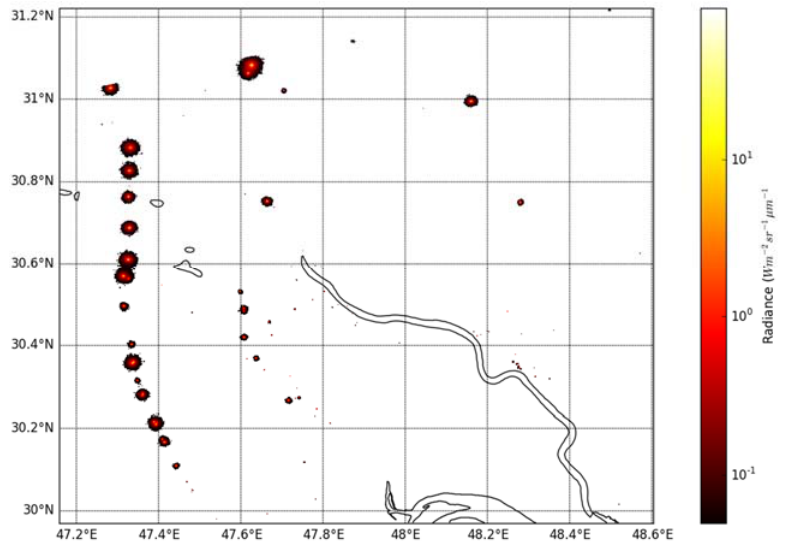
Figure A2. Cloud-free OLI Band 6 (1.6 µ m) nighttime image of the Southern Iraq study region, obtained at 18:40 on 28th January 2015. Flare hotspots used in the FRP intercomparison with VIIRS are easily seen, with the flare mask described in Appendix A applied to the image and the SWIR signal converted to spectral radiance (logarithmic colour scale applied). See Figure 5 location 2 for the geographic location of the ROI.